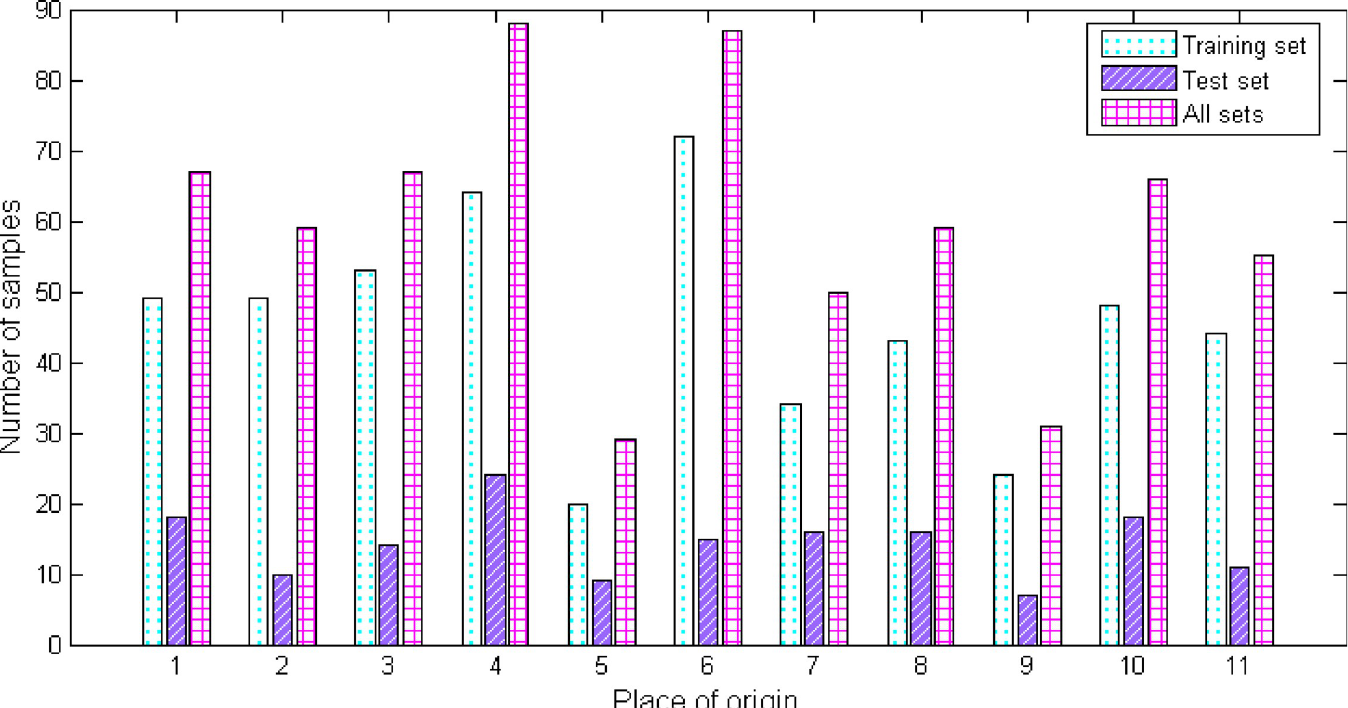
Fig 4. The number of samples in the training set, test set and all sets of Cornus officinalis from different origins.